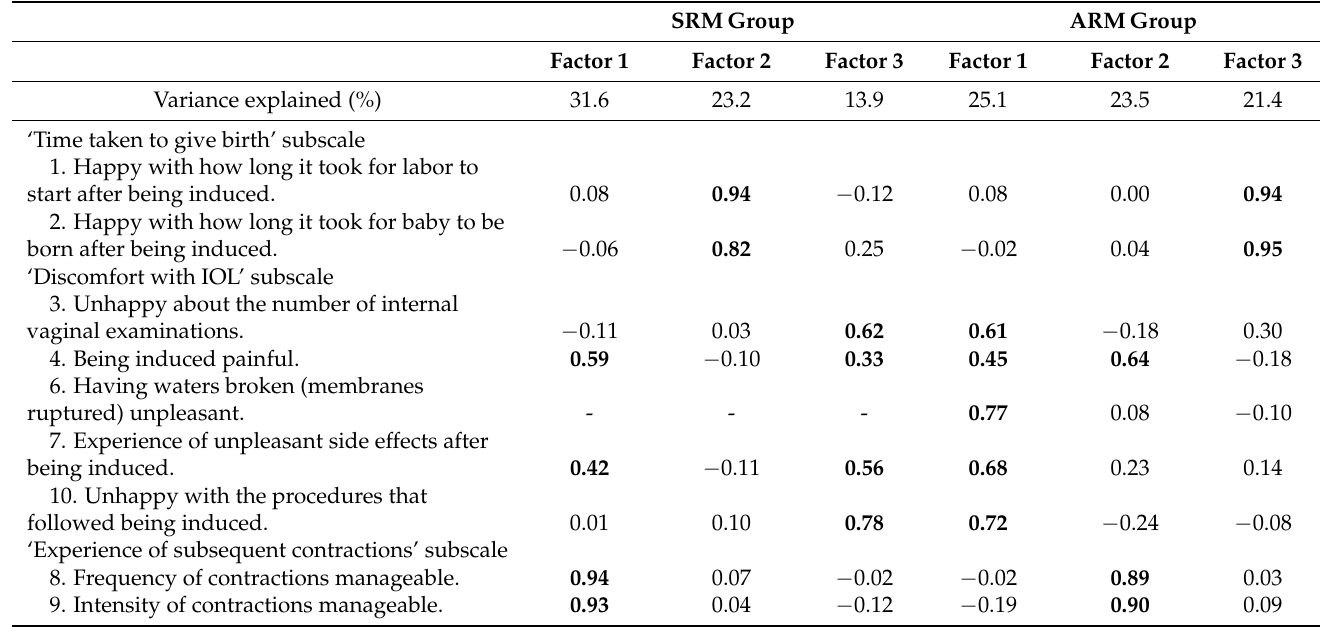
Table 2. Factor loadings from the factor analysis of EXIT-French items measuring women’s experi- ences of